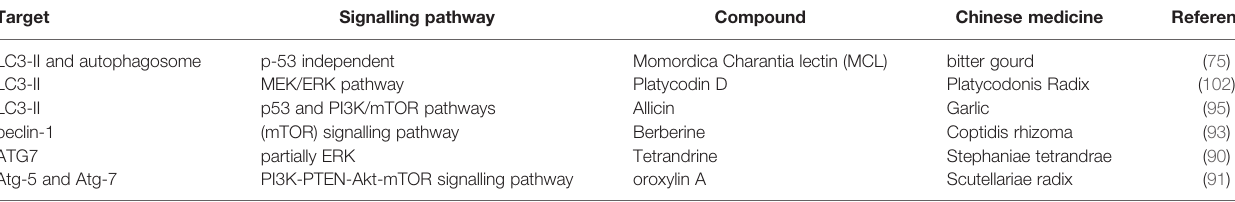
TABLE 3 | The targets and pathways of natural compounds in the process of inhibiting autophagy in HCC.